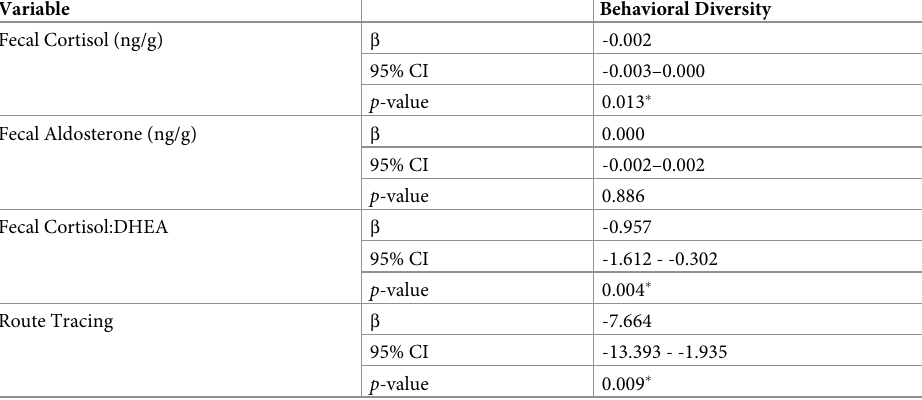
Table 3. Results from generalized estimating equations examining the relationship between behavioral diversity and hormone levels in bottlenose